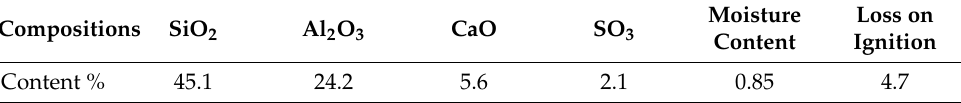
Table 4. Main compositions of FA (%).